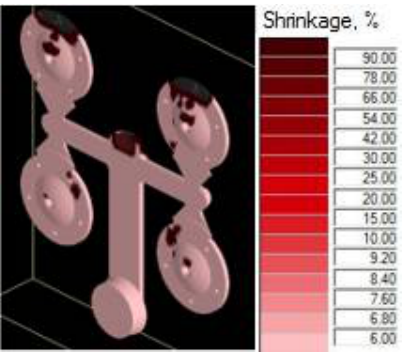
Figure 10. Distribution of defects in gating system—contractions 5.4%.